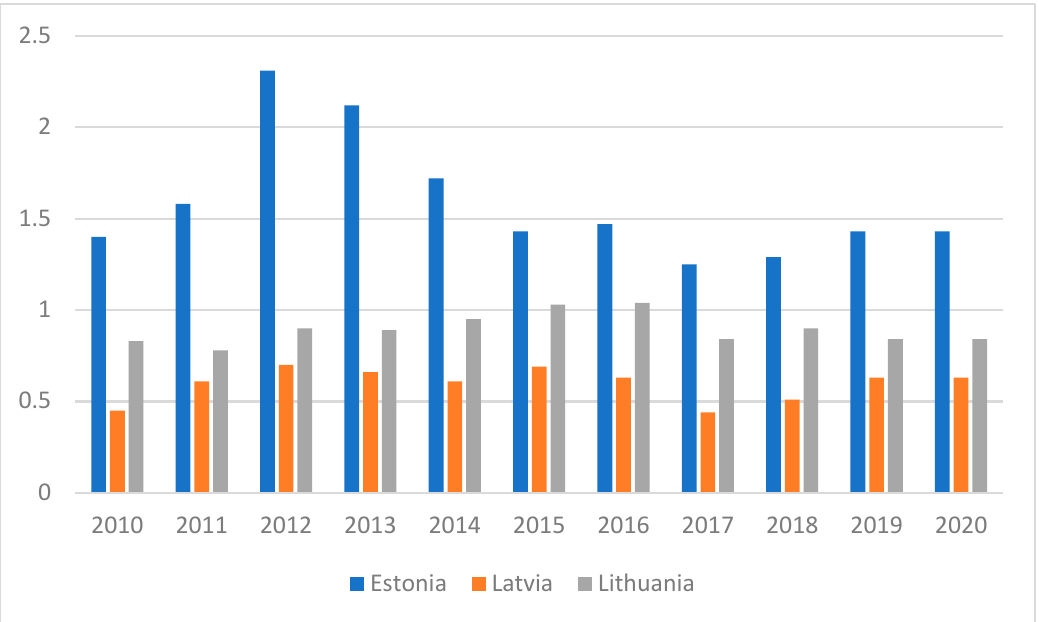
Figure 5. Research and development expenditure dynamics in the Baltic states over the period of 2010–2020. After reviewing the dynamics of the relevant indicators and proceeding further into terms of their investment attractiveness (see Table Table 4. Assessment of investment attractiveness of the Baltic states based on the TOPSIS method (with different weight factors).